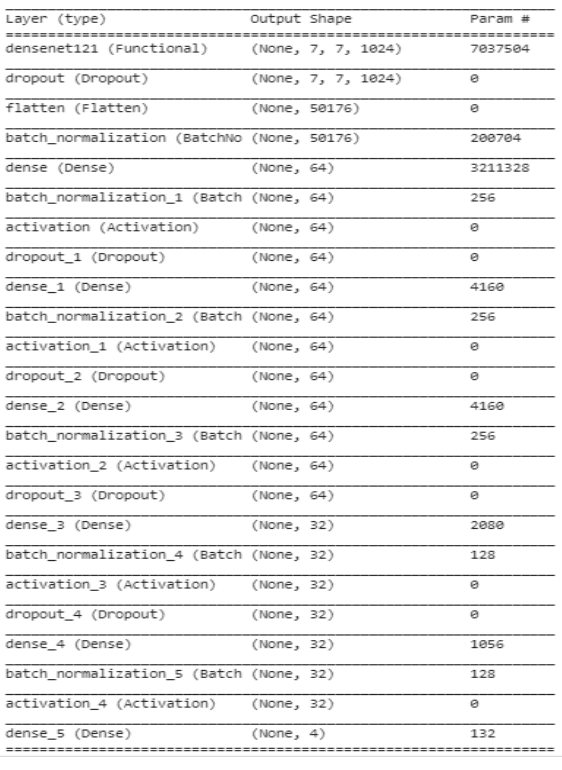
Fig 4.5: DenseNet